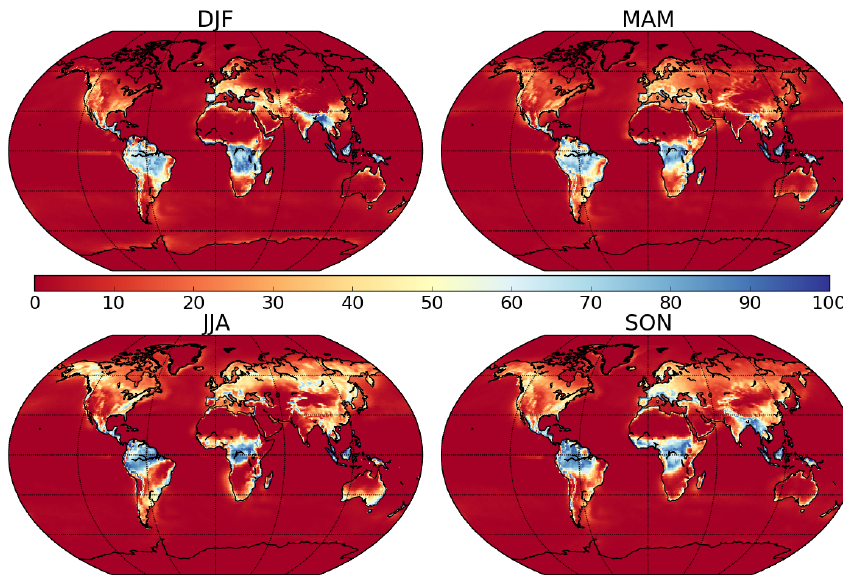
Figure 5. Seasonal occurrence of dew as a fraction of days (%) with a threshold of 0.1mmd − 1 .